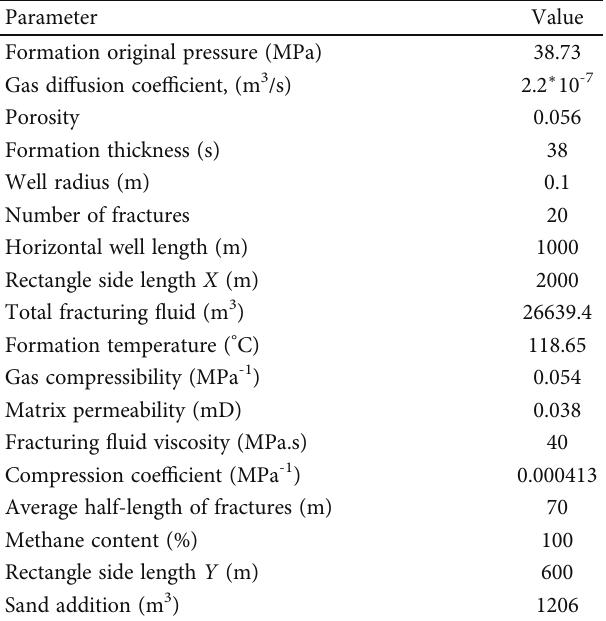
Table 1: Basic parameters of a shale gas